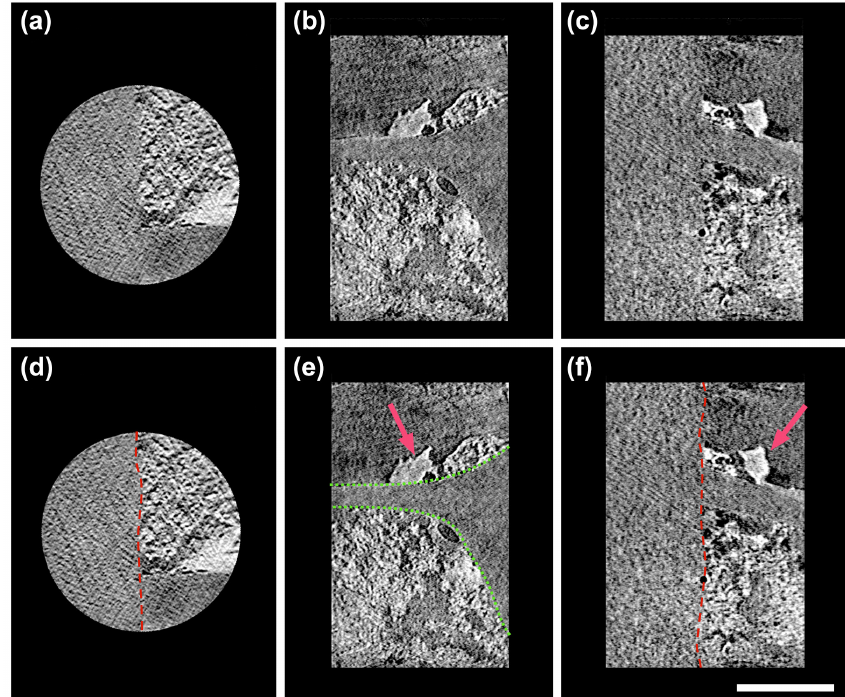
Figure 4. Three-directional orthogonal sections of natural mineral-bearing OC from absorption contrast tomography ( a for xy plane, b for xz plane, and c for yz plane). The scale bar is 5µm. Minerals mainly exhibit two types of textures, subhedral particles and anhedral nano- aggregates/clusters. The images in the lower row highlight the free surface of specimen (red line in d ), the boundary of OC (green dotted line in e ), and the subhedral mineral particles (pink arrow in e and f ).